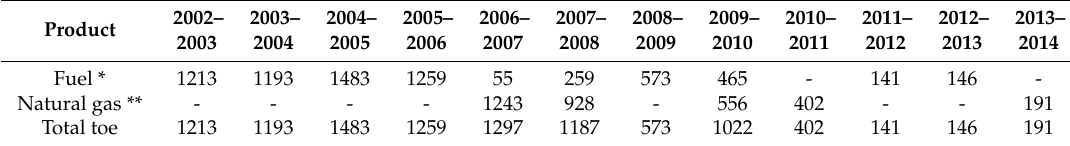
Table 7. Toe by type of fuel. * 1000 kg fuel = 0.96 toe; ** 10 m 3 Natural gas = 0.928 toe.